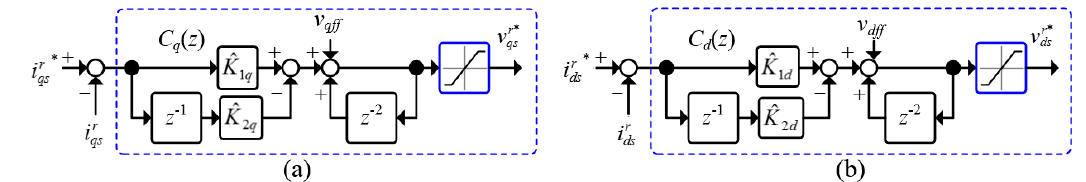
Figure 7. Block diagram of the deadbeat controller with the decoupling voltage and voltage limitation block, ( a ) C q ( z ) and ( b ) C d ( z ).